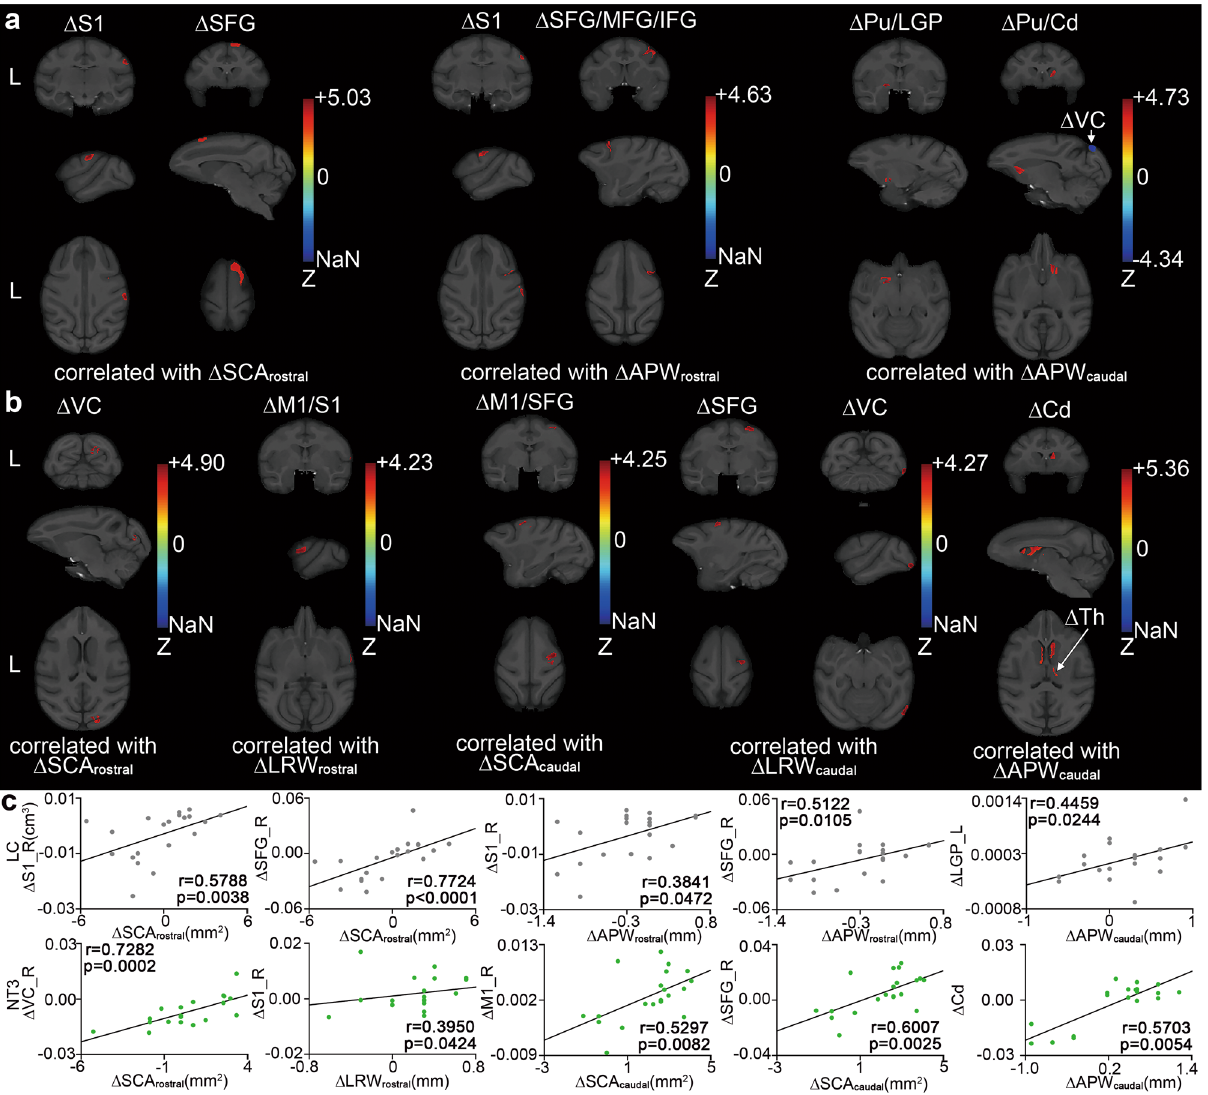
Figure 4. Correlations between brain and spinal cord structural alterations in LC and NT3 animals. ( a ) The brain regions of the LC animals where GMV alterations were significantly correlated with spinal cord structural alterations. ( b ) The brain regions of NT3 animals where GMV alterations were significantly correlated with spinal cord structural alterations. Only clusters with significant correlation were displayed. Correlation analysis with GRF correction; the voxel level was set to p < 0.001, and the cluster level was set to p < 0.05. The brain regions in which the significant clusters were located are presented above the images or indicated by the arrow. The correlated spinal cord structural parameters were presented below the images. A positive value in the Z-bar indicated that LC > NT3. L indicated the left side. ( c ) The results of the correlation analysis between the overall GMV alterations in the above brain regions and the spinal cord structural alterations. Only brain regions with significant correlation were presented (Spearman correlation analysis). LC lesion control, NT3 neurotrophin-3, SCA spinal cord area, LRW left–right width, APW anterior–posterior width, S1 primary somatosensory cortex, SFG superior frontal gyrus, MFG middle frontal gyrus, IFG inferior frontal gyrus, Pu putamen, LGP lateral globus pallidus, Cd caudate nucleus, VC visual cortex, M1 primary motor cortex, Th